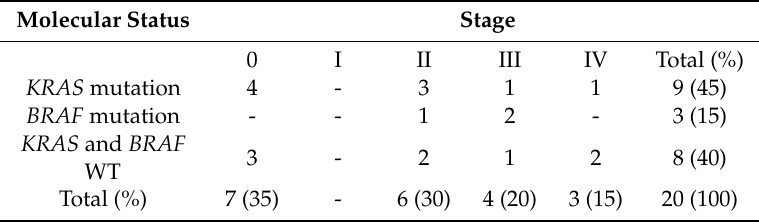
Table 1. Molecular status of colorectal cancers according to the tumor